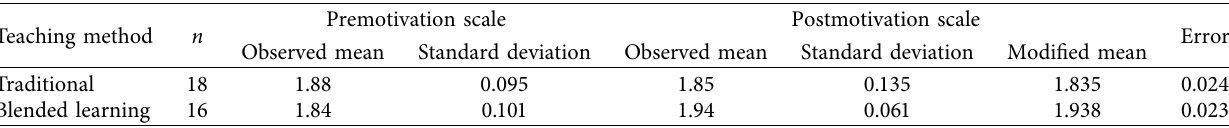
Table 4: Arithmetic observed and modified means of pre- and post-English language learner motivation scale.